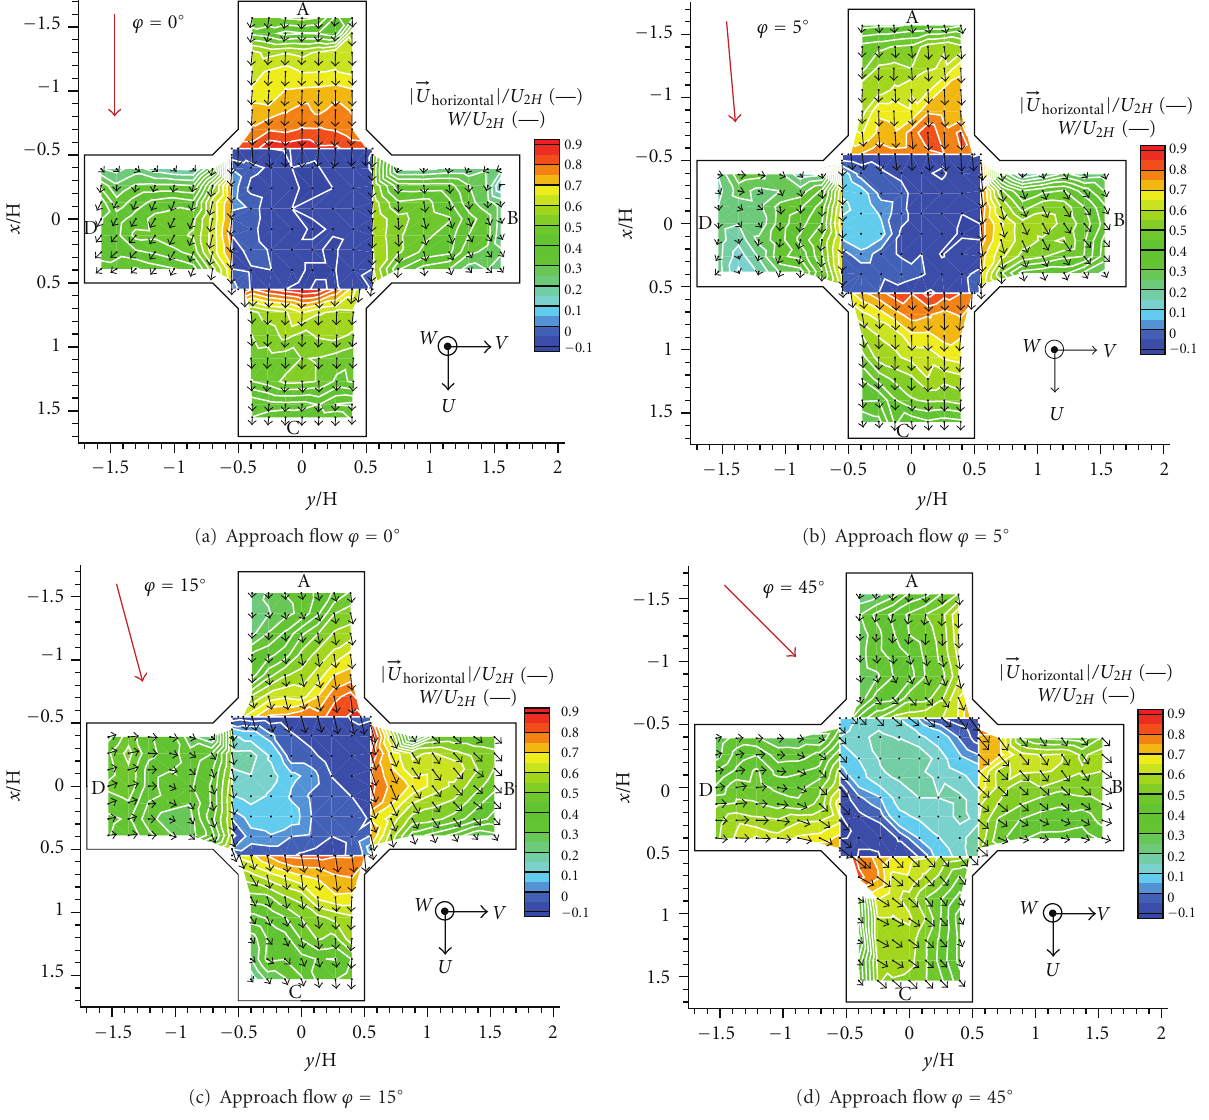
Figure 7: Dimensionless velocity fields for four angles of the approach flow